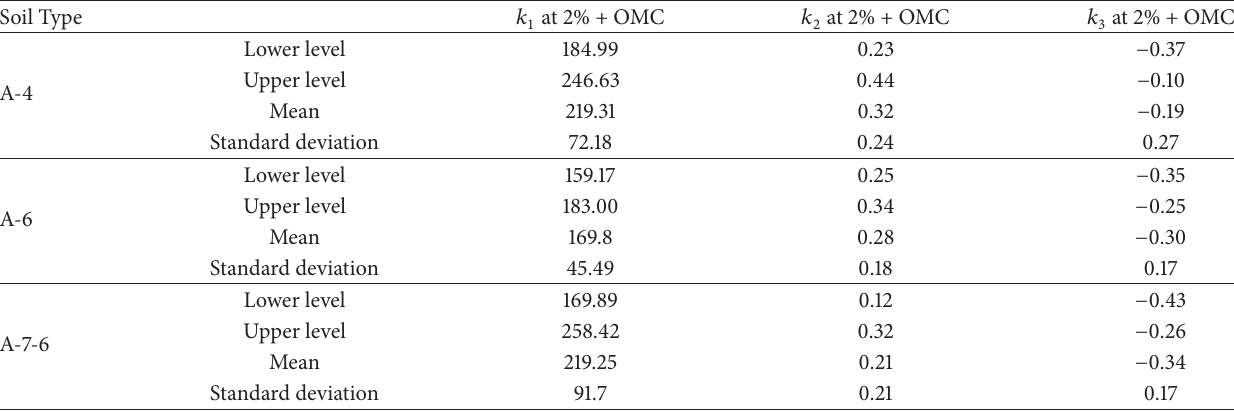
Table 7: MEPDG Level 1 for 2% + OMC.